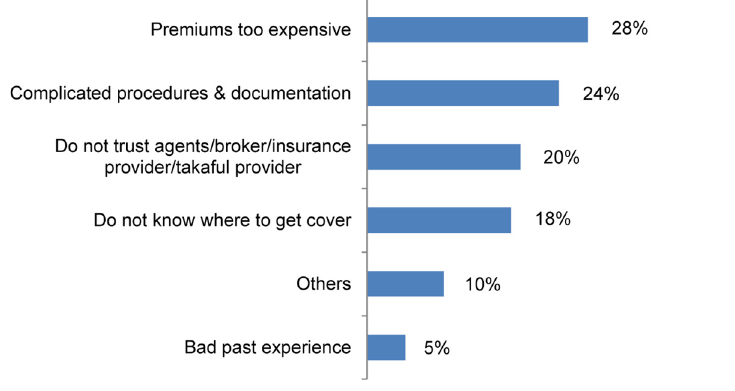
Figure 16. Distribution of